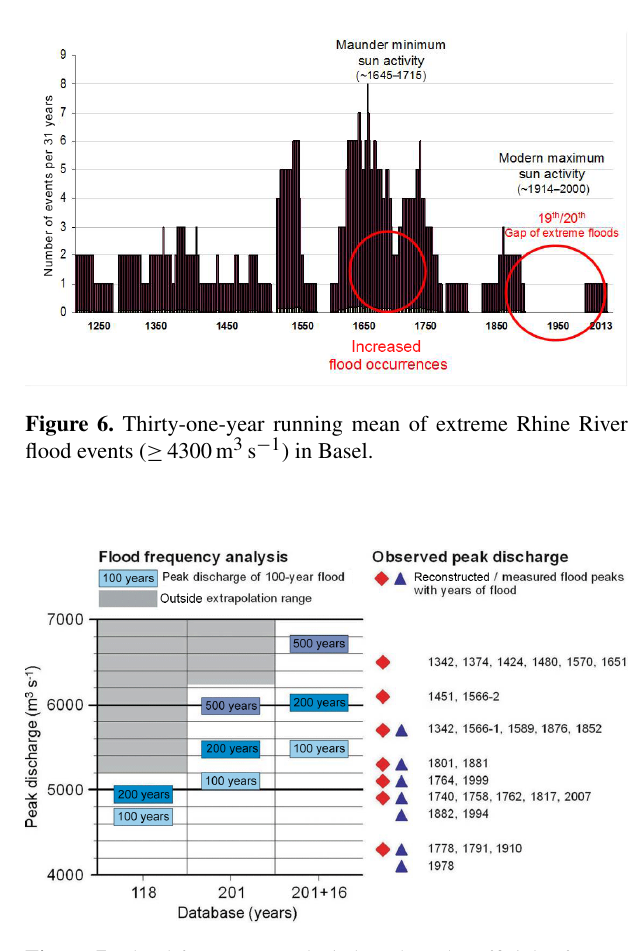
Figure 7. Flood frequency analysis based on the official reference period (1891–2008), the full instrumental period (1808–2008) and the full instrumental period plus 16 reconstructed pre-instrumental flood discharges for the Rhine River in